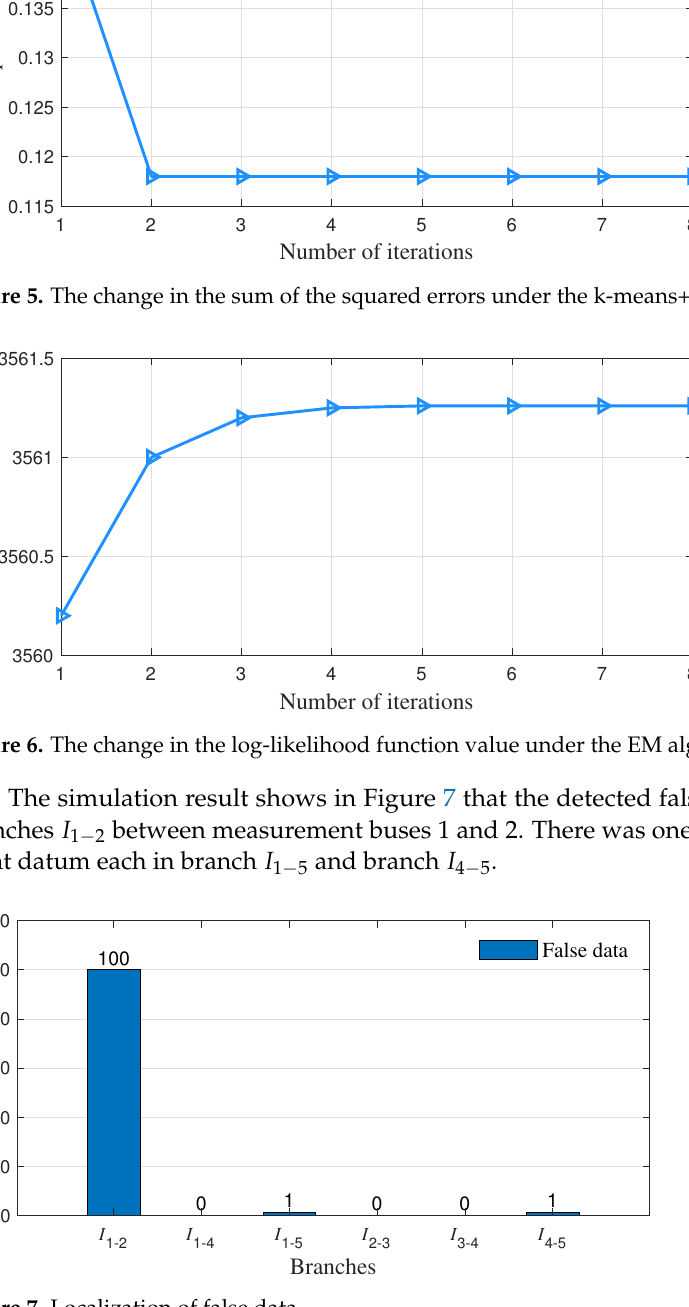
Figure 7. Localization of false